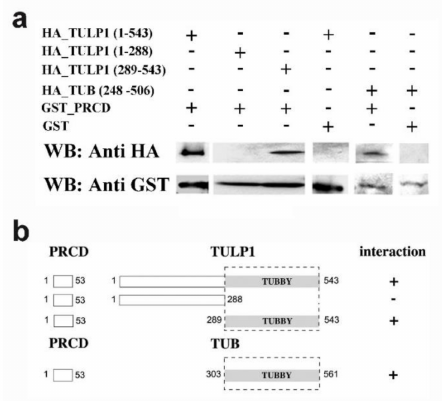
Figure 3. Mapping the interacting regions between PRCD, TULP1, and TUB. ( a ) Pull-down experiments were performed to test the interaction between PRCD_GST and truncated TULP1_HA and TUB_HA. SampleswereanalyzedbyWesternblotwithanti-HAandanti-GSTantibodies.